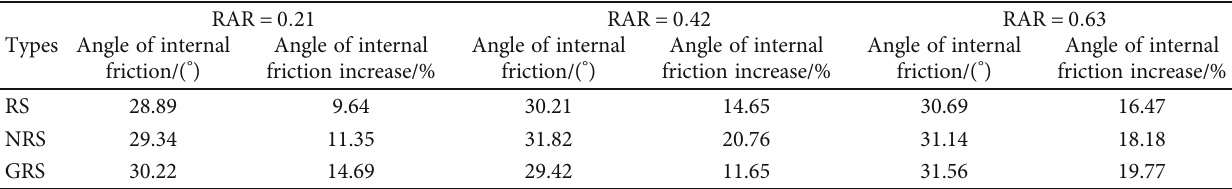
Table 5: Internal friction angle and growth range of